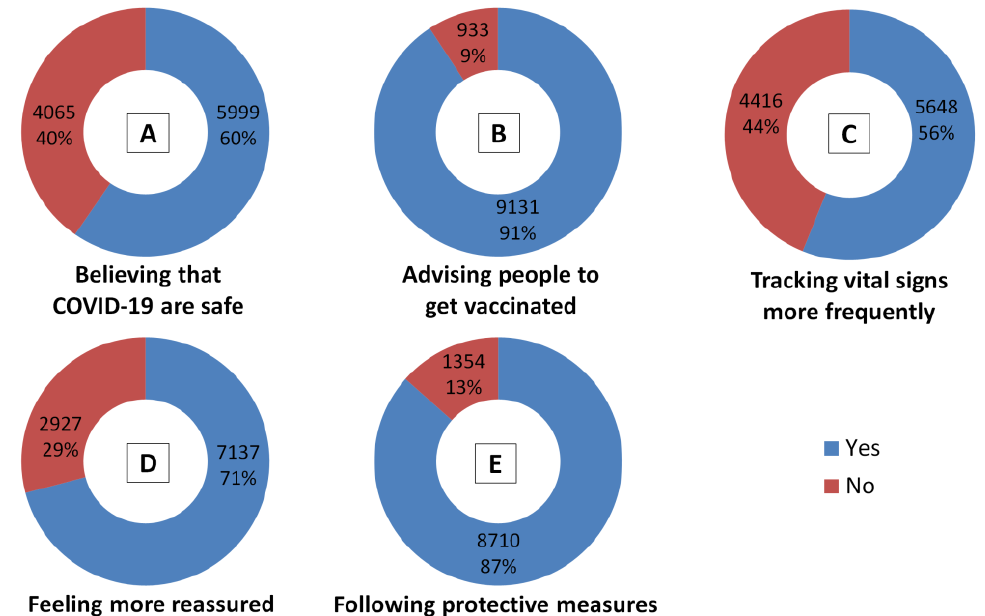
Figure 5. Participants’ responses to belief-based questions after COVID-19 vaccination. Table 4. Assessment of the statistical association between predisposing factors and side effects of COVID-19 vaccines using χ 2